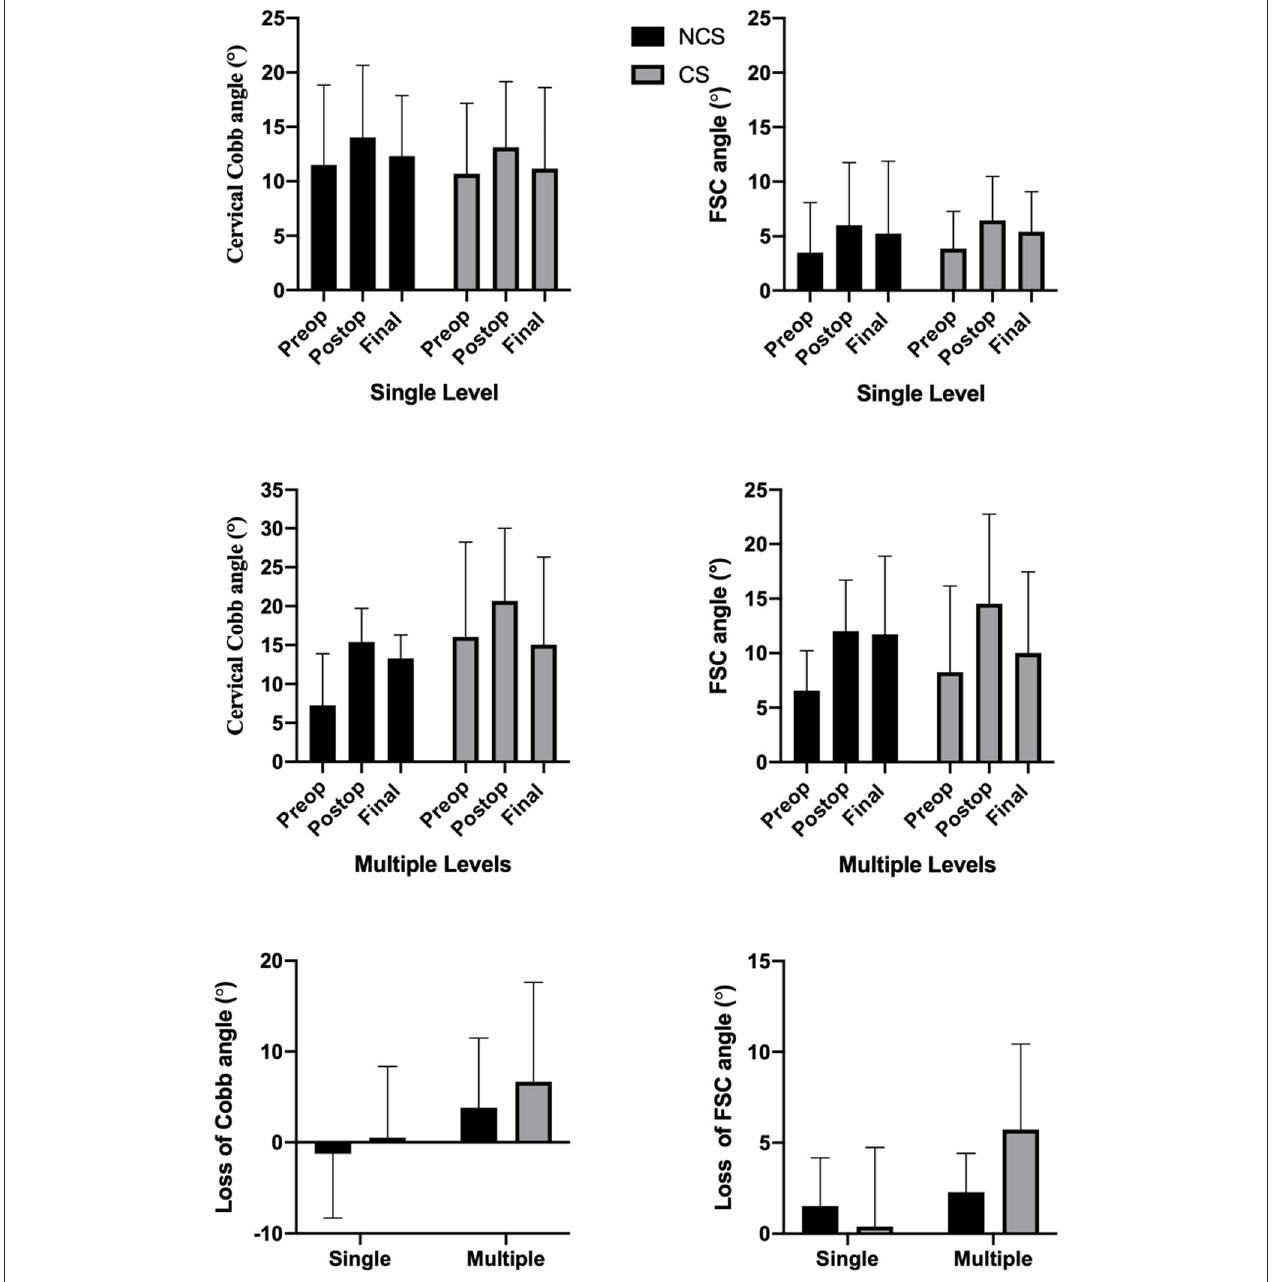
FIGURE 3 | The mean cervical Cobb angle, FSC angle, the loss of mean Cobb angle, and FSC angle in single level and multiple levels between CS and NCS groups.